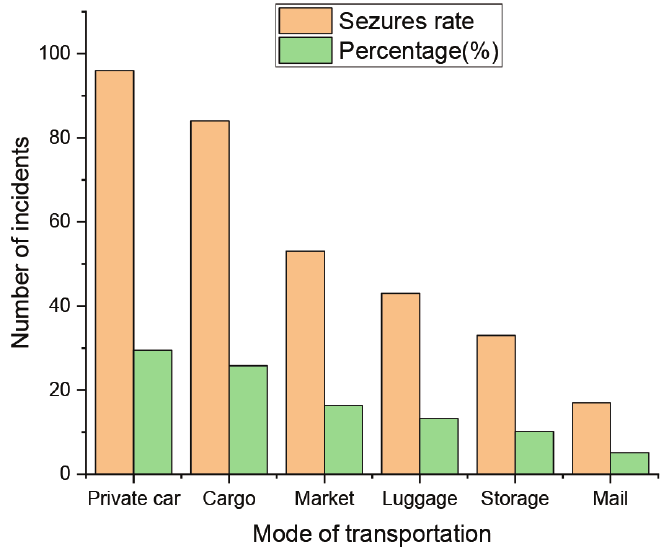
Figure 6. Proportion of pangolin seizure incidents from a different form of